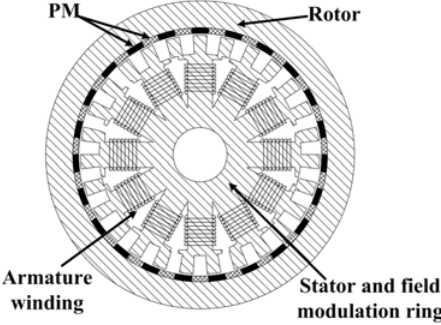
Figure 15. Magnetic-geared motor with a single airgap.